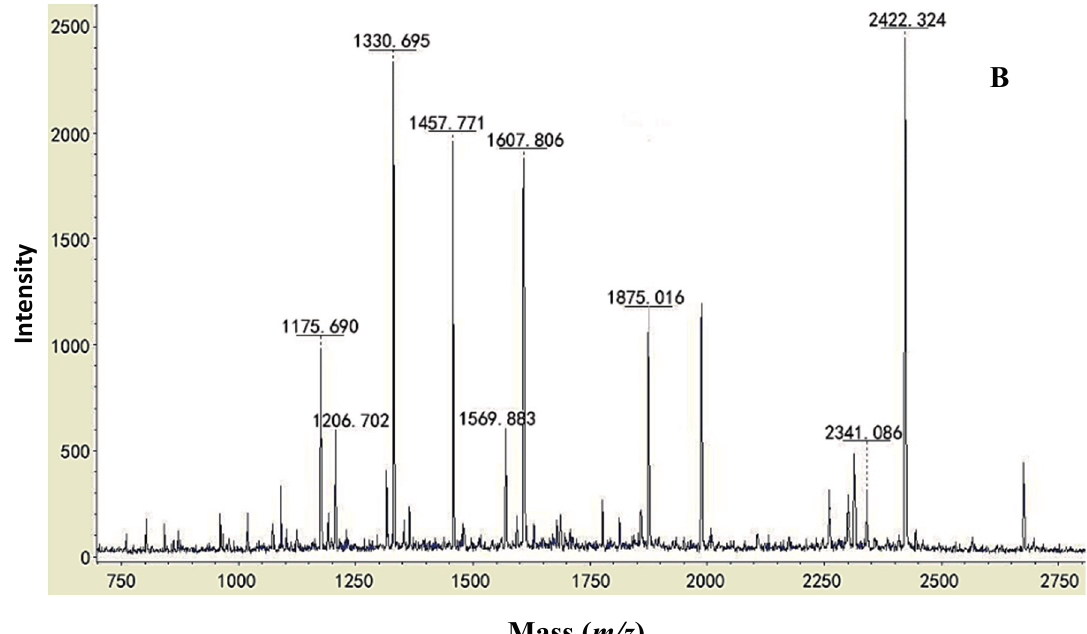
Figure 2. Type identification of GlcDH from A. globiformis C224. ( A ) SDS-PAGE of GlcDH from A. globiformis C224. Lane 1: standard marker proteins: phosphatase b (97,200 Da), bovine serum albumin (66,409 Da), ovalbumin (44,287 Da), carbonic anhydrase (29,000 Da) and trypsin inhibitor (20,100 Da). Lane 2: purified GlcDH; ( B ) Mass spectra of peptides of GlcDH from A. globiformis C224 by MALDI-TOF-MS.